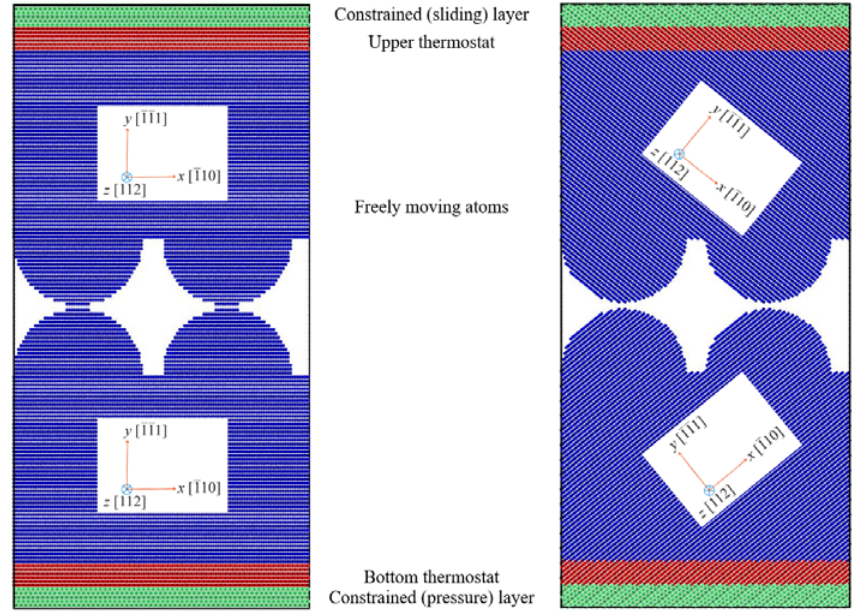
Figure 1. Schematic representation of atomic models used for atomistic simulation of USW.